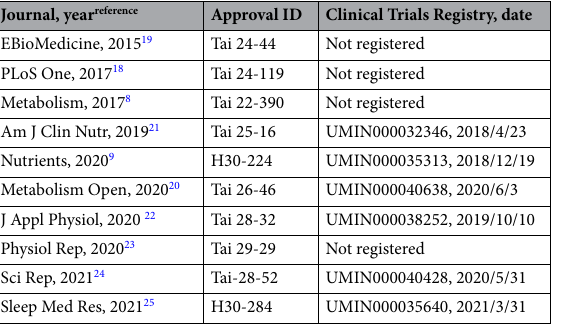
Table 1. Approval ID by the local ethics committee, and Clinical Trials Registry of the studies. All study protocols were approved by the local ethics committee of the University of Tsukuba, and its approval ID was shown. Clinical Trials Registry was not applied for 4 observational studies 8,18,19,23